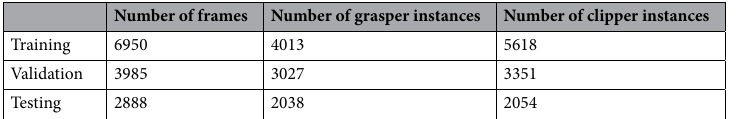
Table 2. Distribution of frames and object instances for instrument